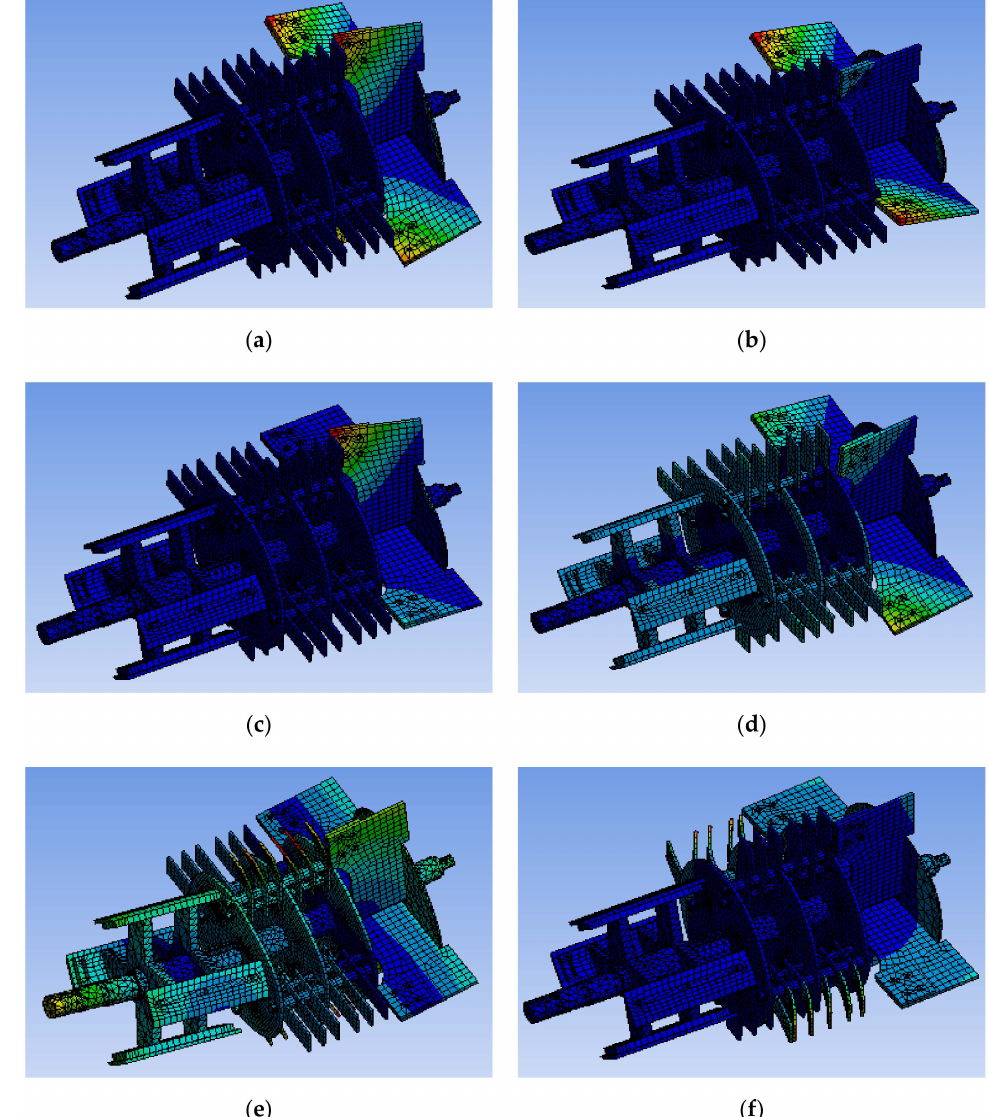
Figure 7. Mode shape diagram of each order. ( a ) The 7th order; ( b ) the 8th order; ( c ) the 9th order; ( d ) the 10th order; ( e ) the 11th order; ( f ) the 12th